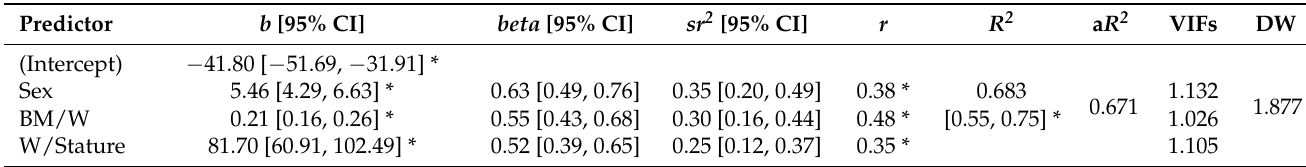
Table 4. Regression results to estimate fat mass using DXA as the